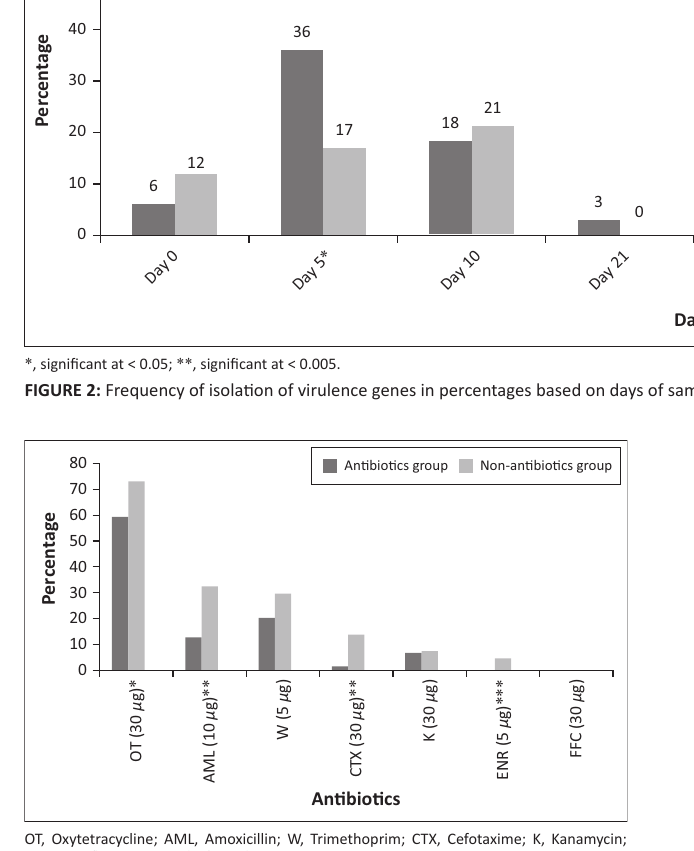
FIGURE 3: Frequency of occurrence of antimicrobial resistance for each of the antimicrobial agents tested in this